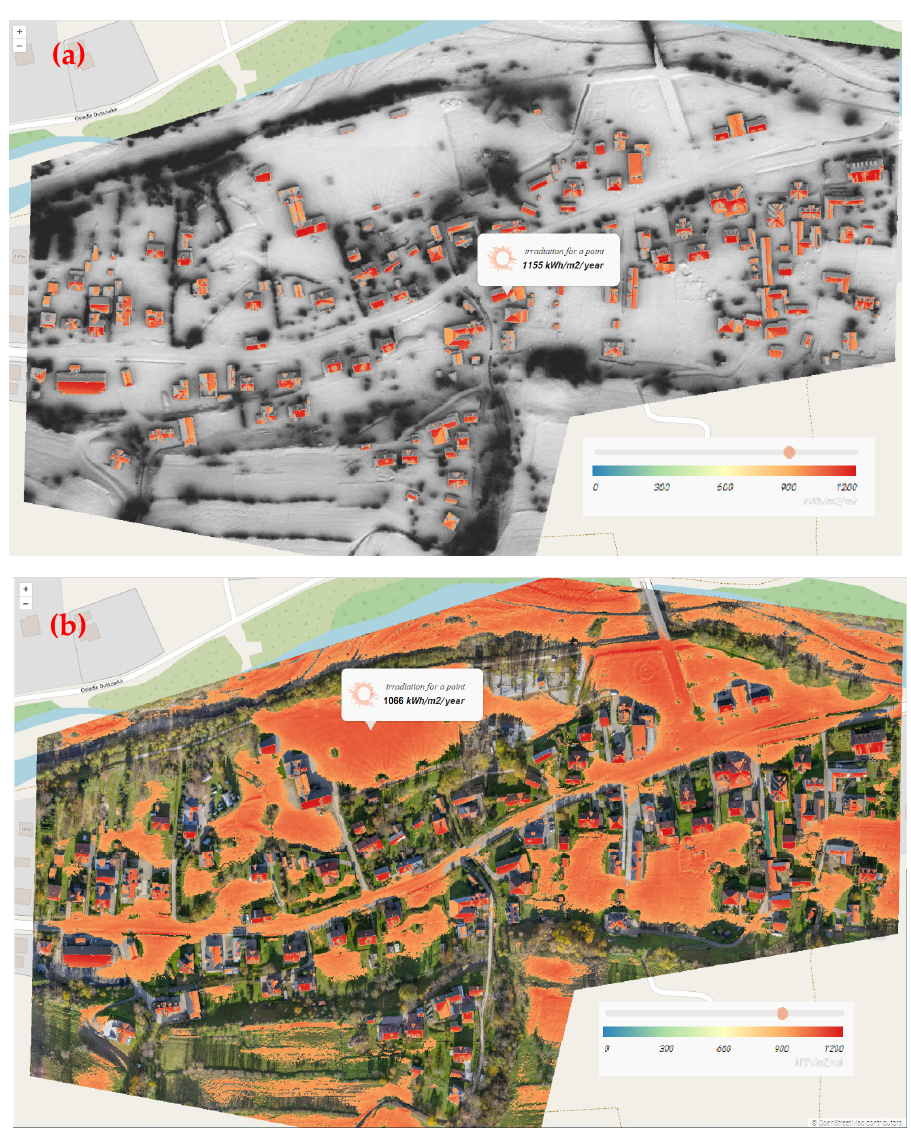
Figure 16. Solar potential map ( a ) for buildings and structures based on a height model ( b ) taking into account the ground on a true orthophoto map basis. Source: Solarmap Sp. z o. o. [49].